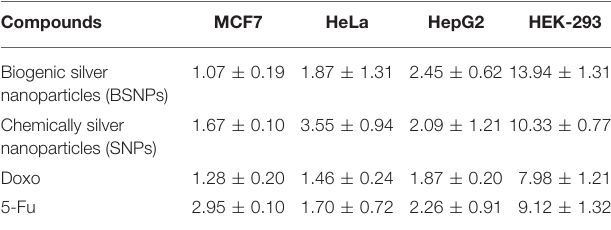
TABLE 3 | Cytotoxic activity (IC 50 ± SD values) µ g/mL of biogenic silver nanoparticles and chemically synthesized silver nanoparticles against human carcinoma cell lines and normal cells